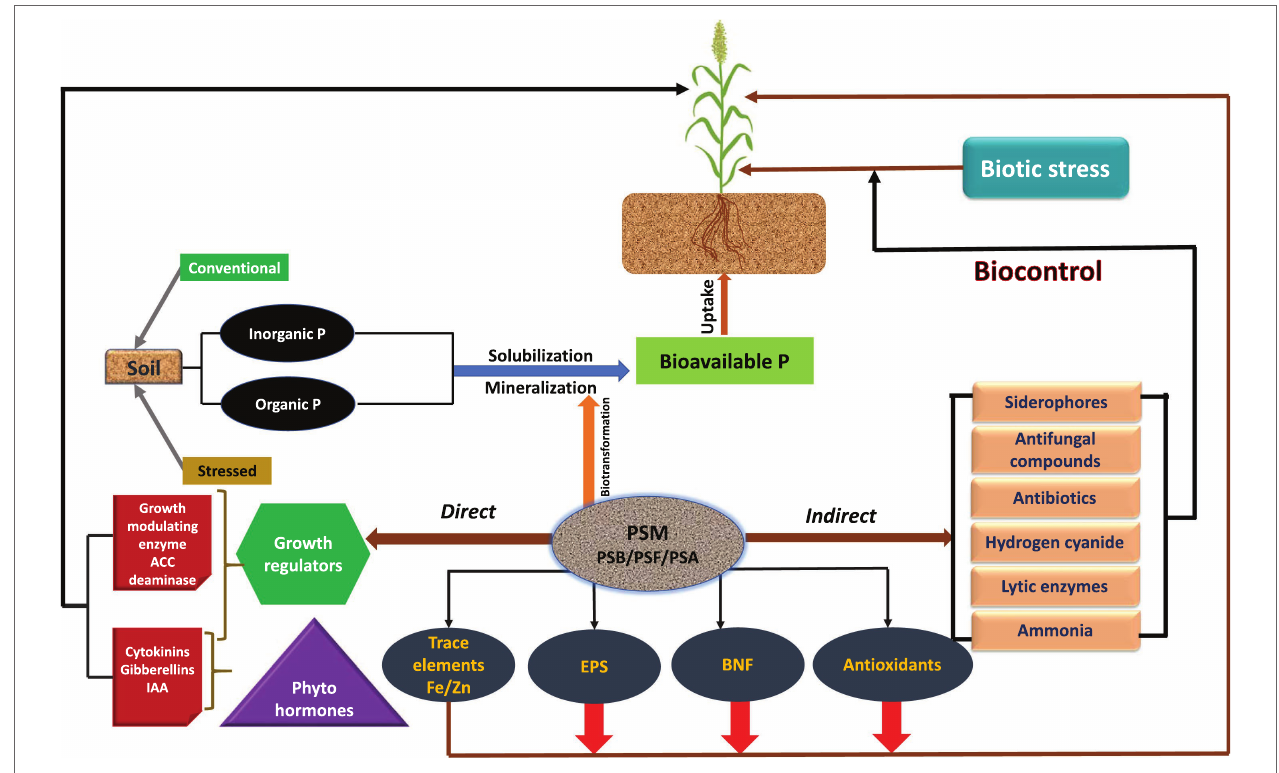
FIGURE 2 | Mechanism used by phosphate solubilizing microbiome (PSM) to facilitate sorghum plant